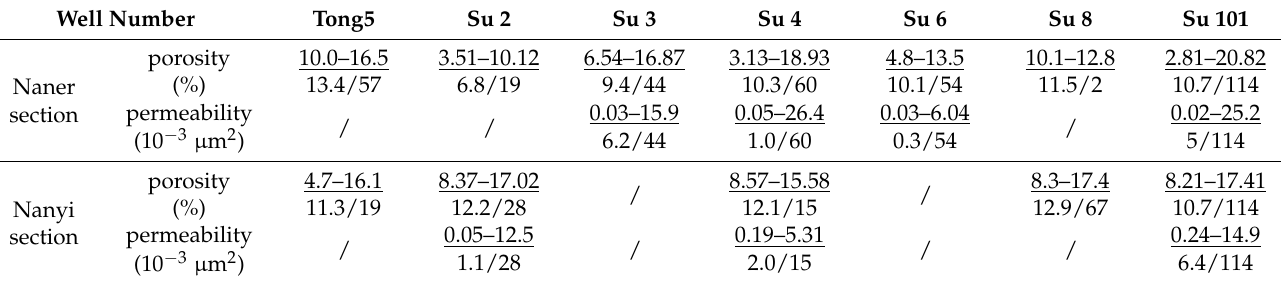
Table 4. Reservoir physical property statistics of CO 2 gas well in Hailar